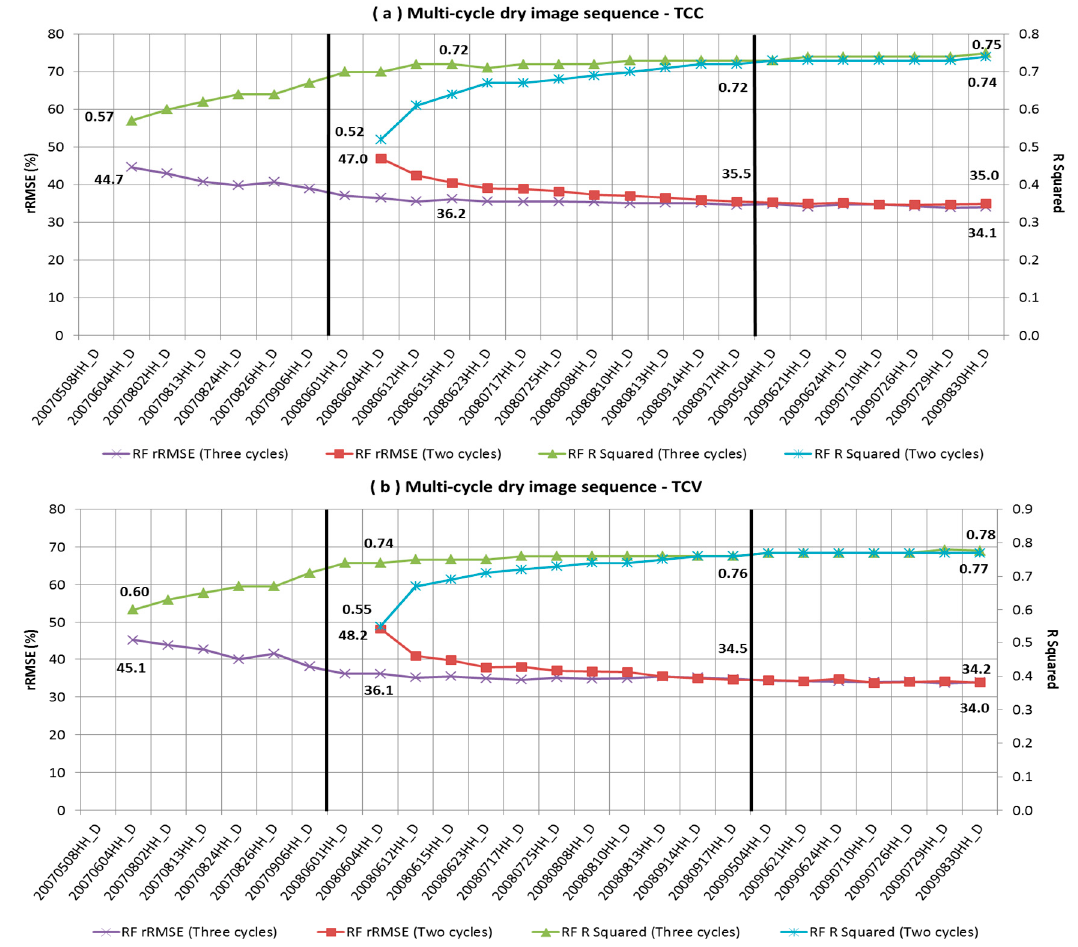
Figure 5. ( a , b ): Results from the sequential addition to the model of dry images from: (i) all three cycles of images; (ii) only two cycles of images, for both TCC ( a ) and TCV ( b ) metrics The first two images of each scenario are used as the starting combination. Data labels are provided for the first result, the approximate plateau, as well as the final result in the sequence.